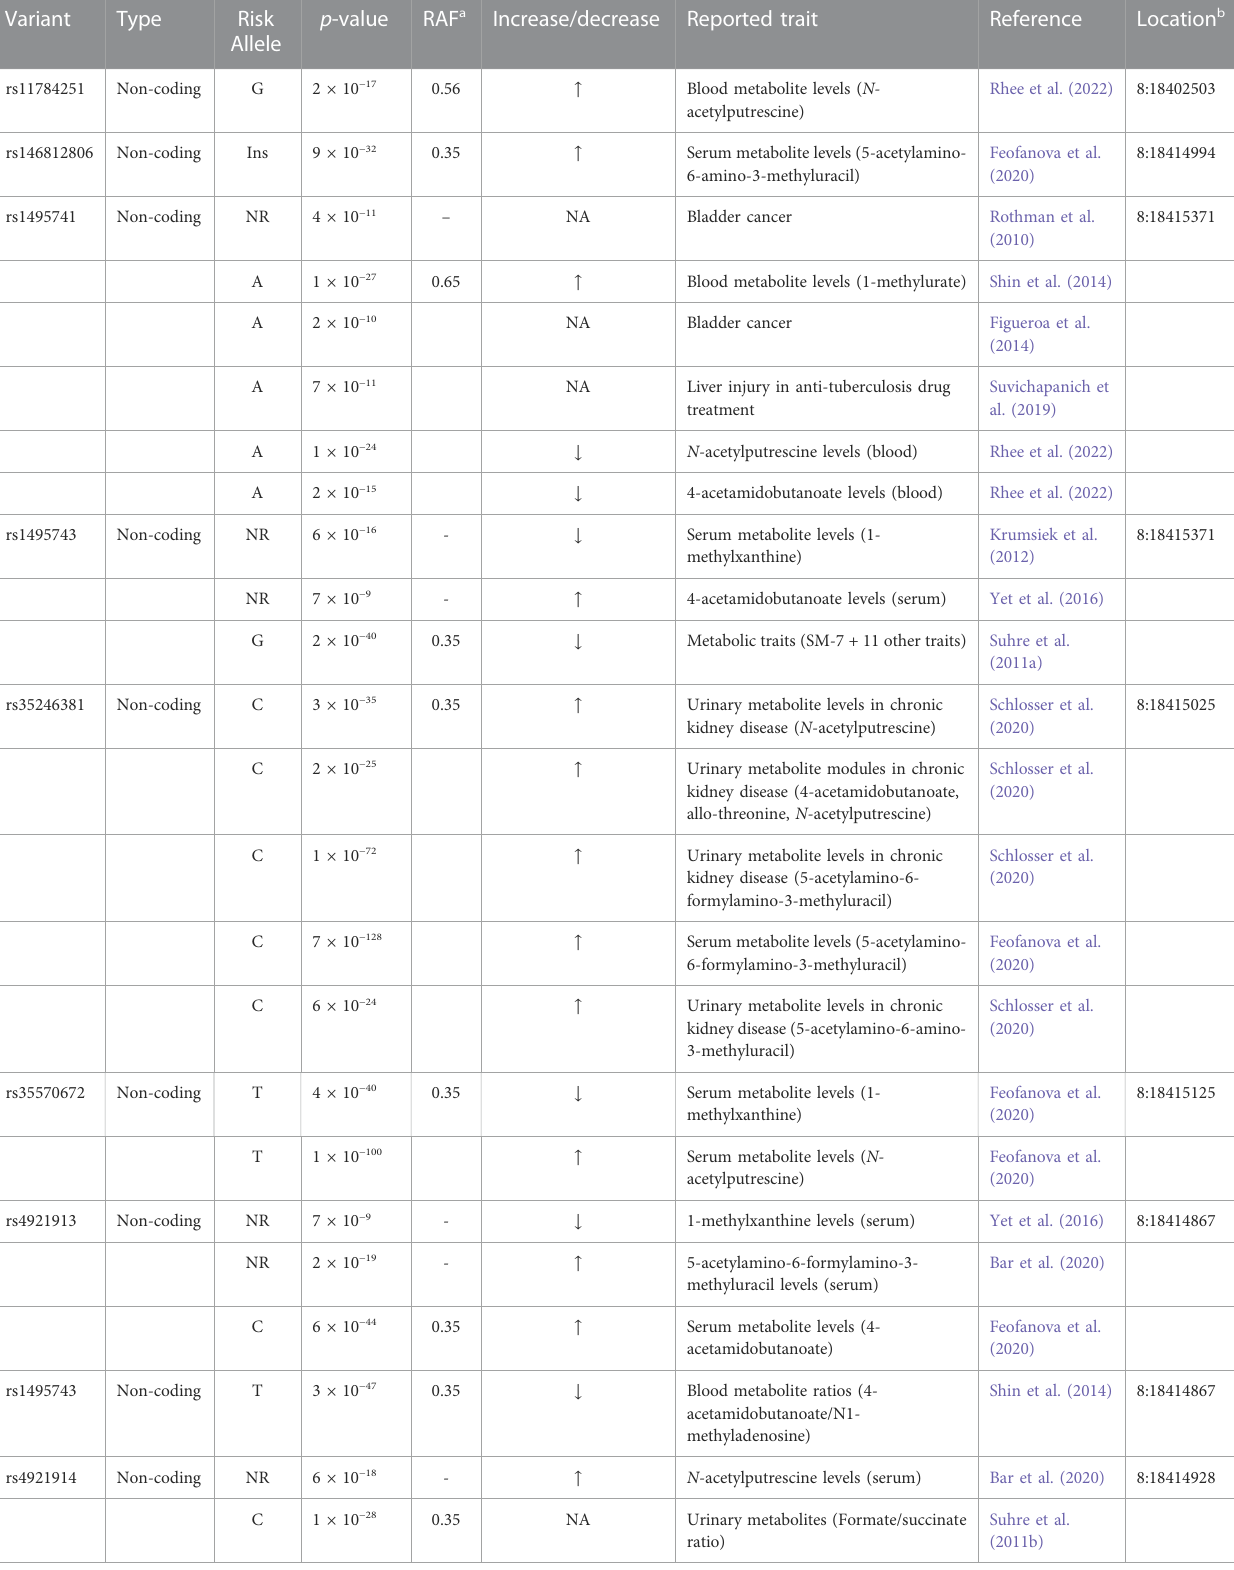
TABLE 2 NAT2 genetic variants associated with differential urinary or serum metabolite levels and other